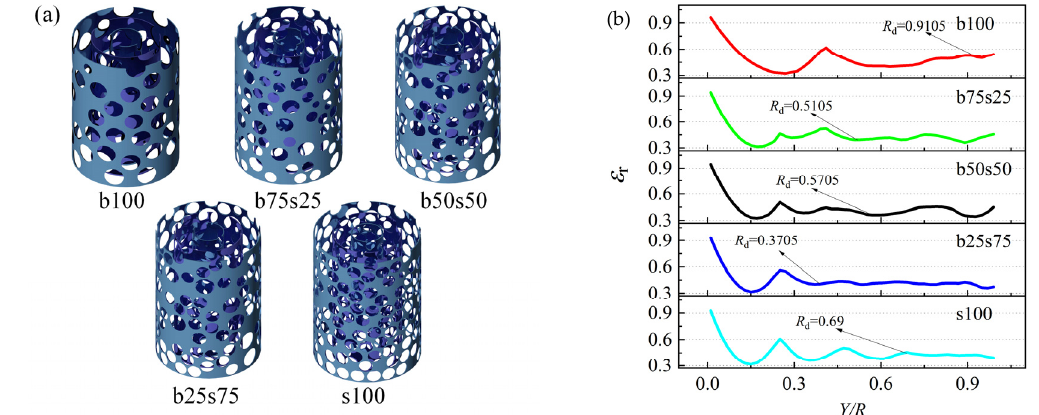
Figure 11. ( a ) Construction of radial pore structure; ( b ) radial porosity distribution.